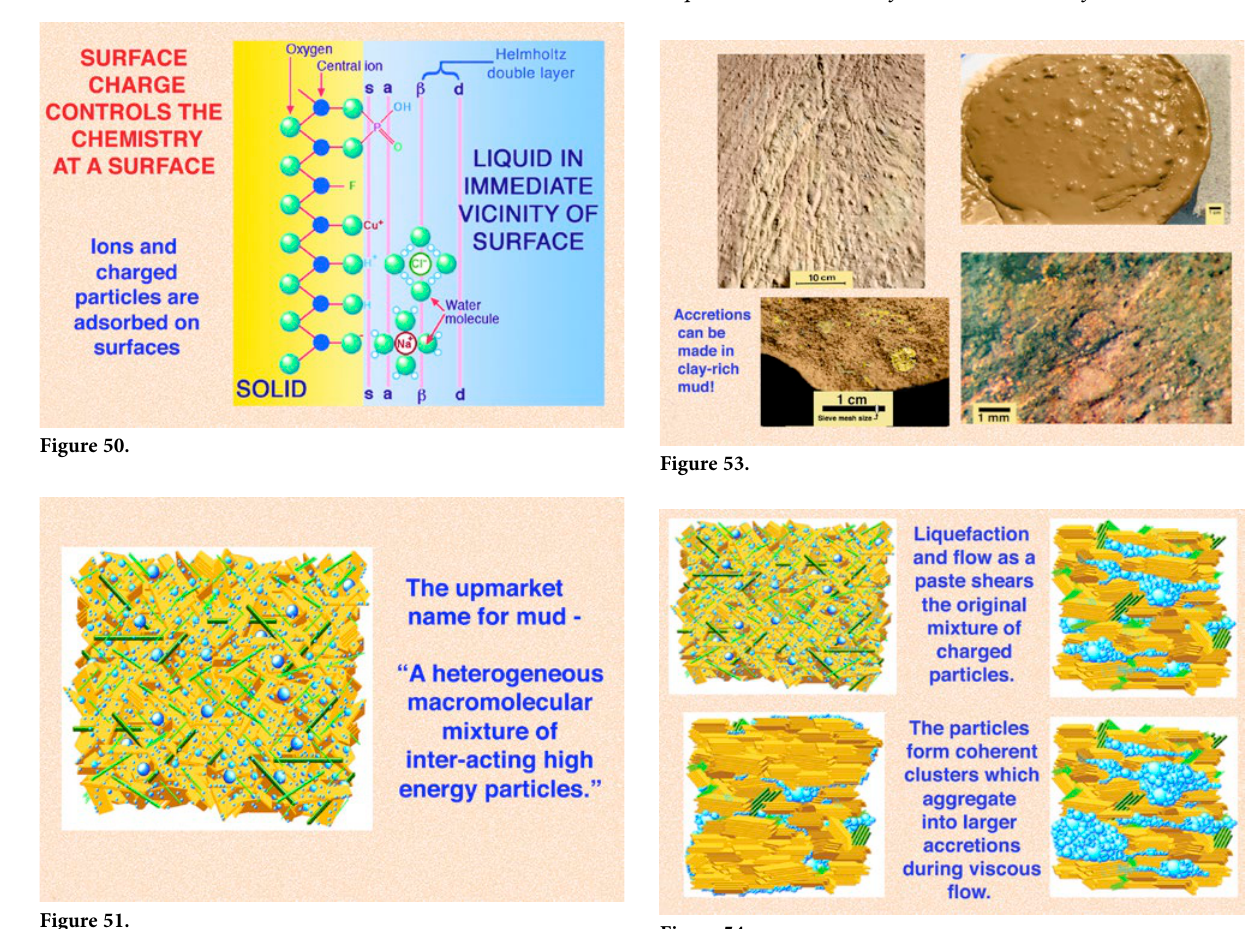
Figure 49. There is an essential difference between what happens in nature and historic geological